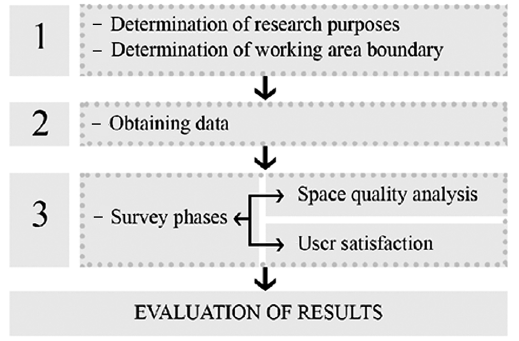
Figure 4. Phases of the study